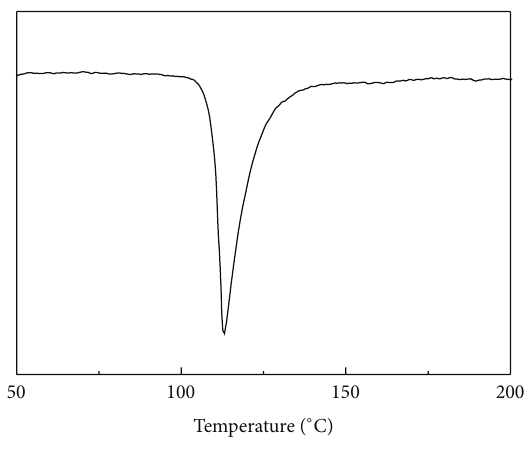
Figure 3: DSC curve of main product of depolymerization.